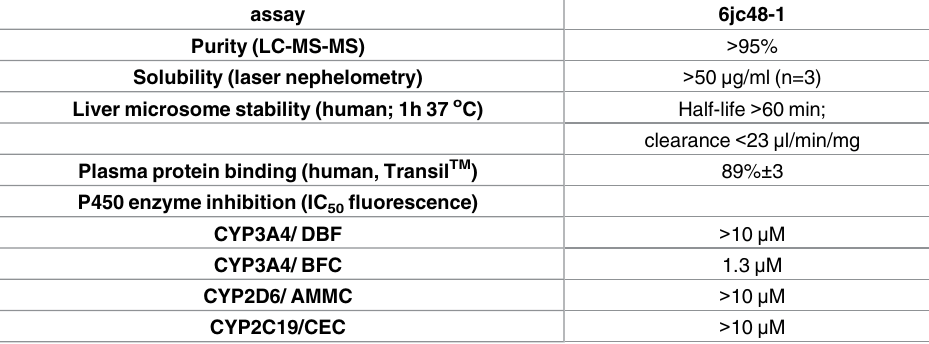
Table 3. In vitro drug-like properties of